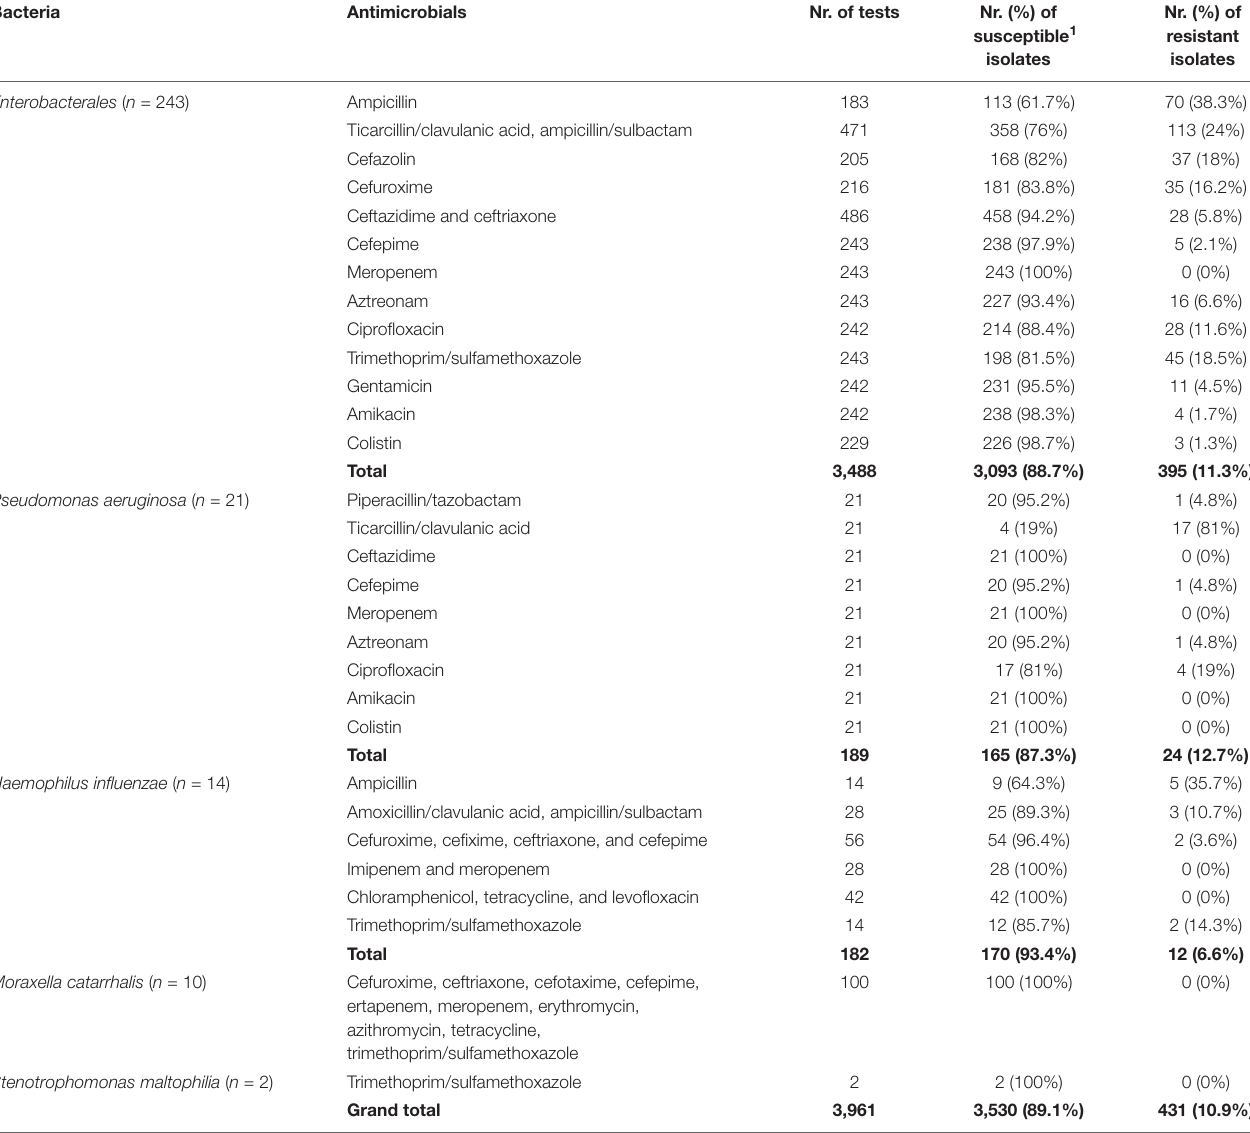
TABLE 3 | Phenotypic AST results obtained through BMD for the main Gram-negative bacterial taxa in this study. Bacteria